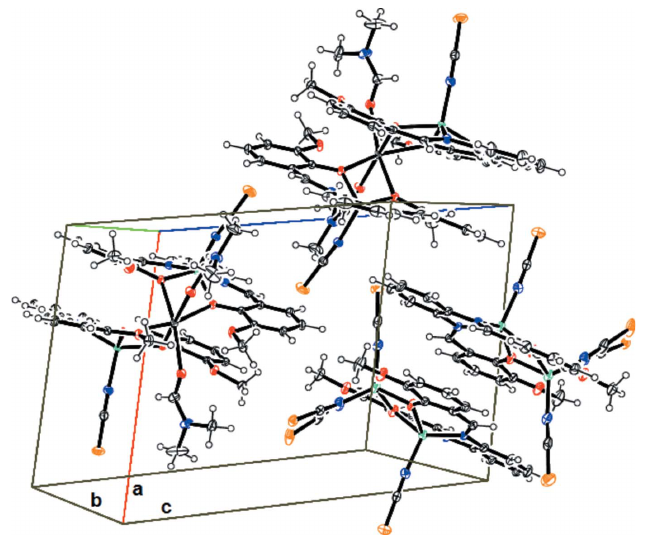
Figure 2 Molecular representation of the title compound, showing the network of dinuclear and trinuclear complex units in